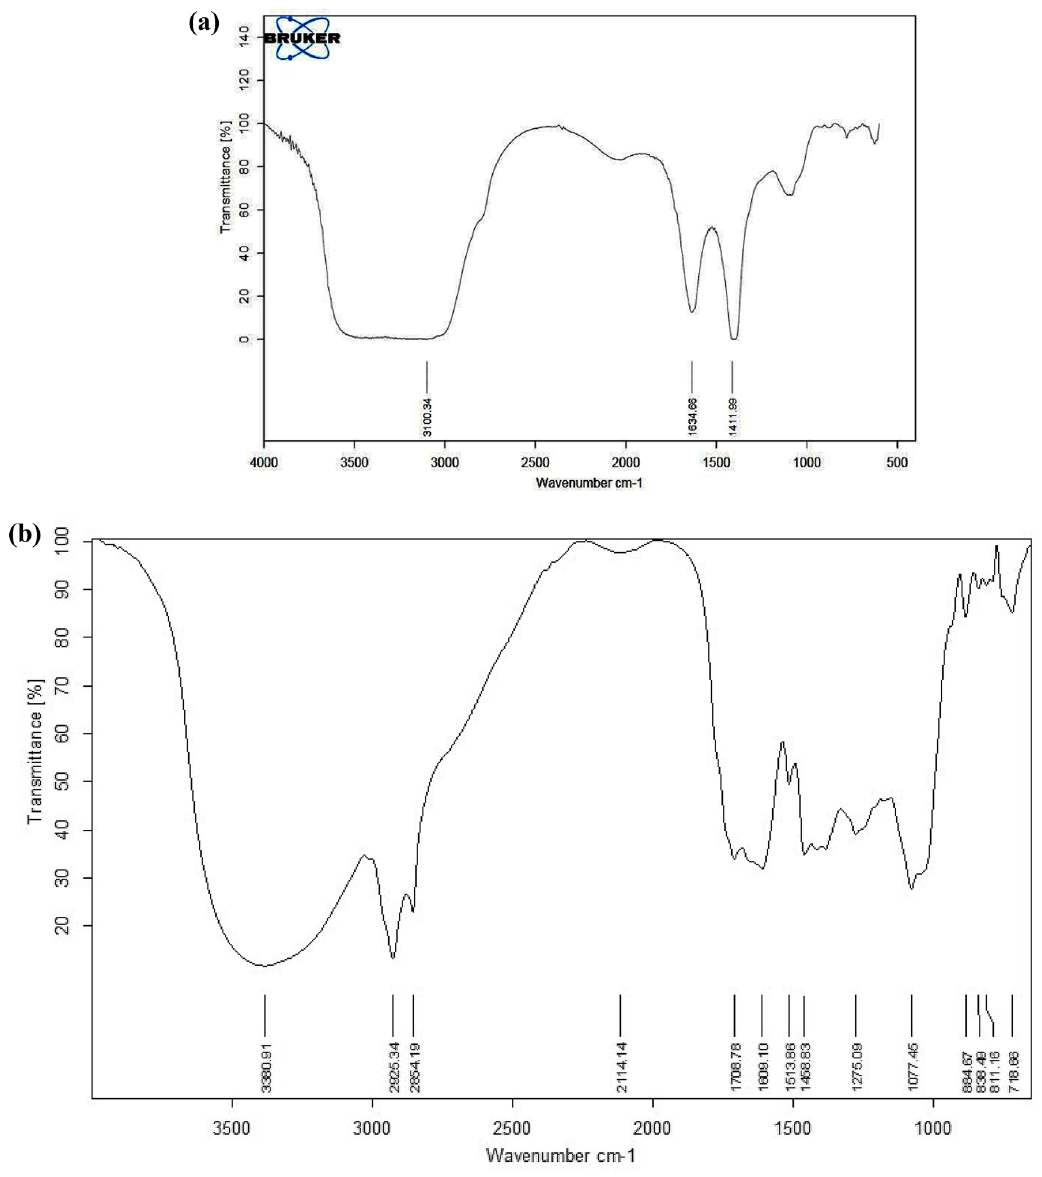
Fig. 4 a FT-IR spectrum of M. wightii leaf extract. b AgNPs FT-IR spectrum of as synthesized through green approach by M. wightii leaf